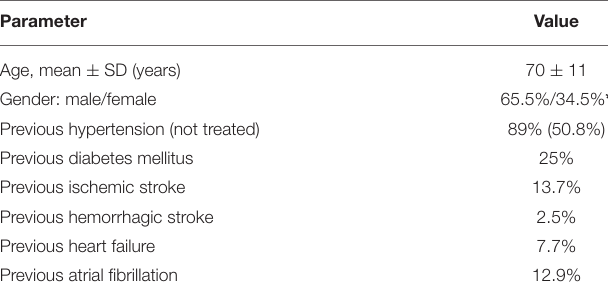
TABLE 1 | Baseline characteristics (main risk factors) of the patients (* p < 0.05; N =